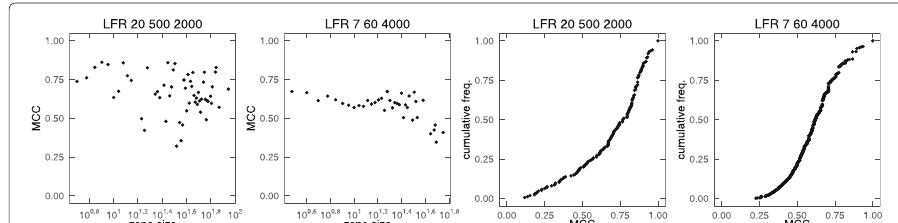
Fig. 16 Match of zones and communities of LFR networks. In LFR networks, there are minimum differences in average match accuracy for different zone sizes. In LFR 205002000 network, there is a large variation in zone and community match accuracy. The frequency of zones in LFR networks is increasing for a lower match accuracy; however, it is decreasing for a very high match. For both networks, most of the zones have a match accuracy above